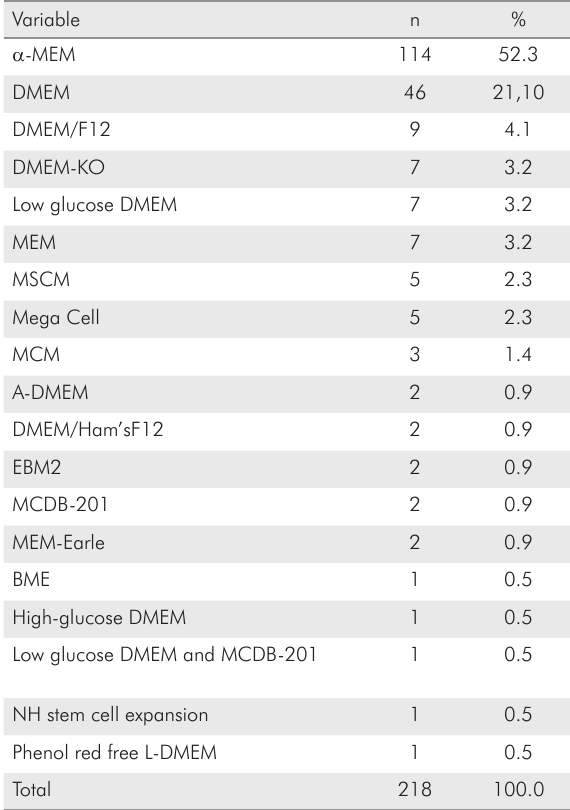
Table 3. Distribution according to the types of medium used for culturing